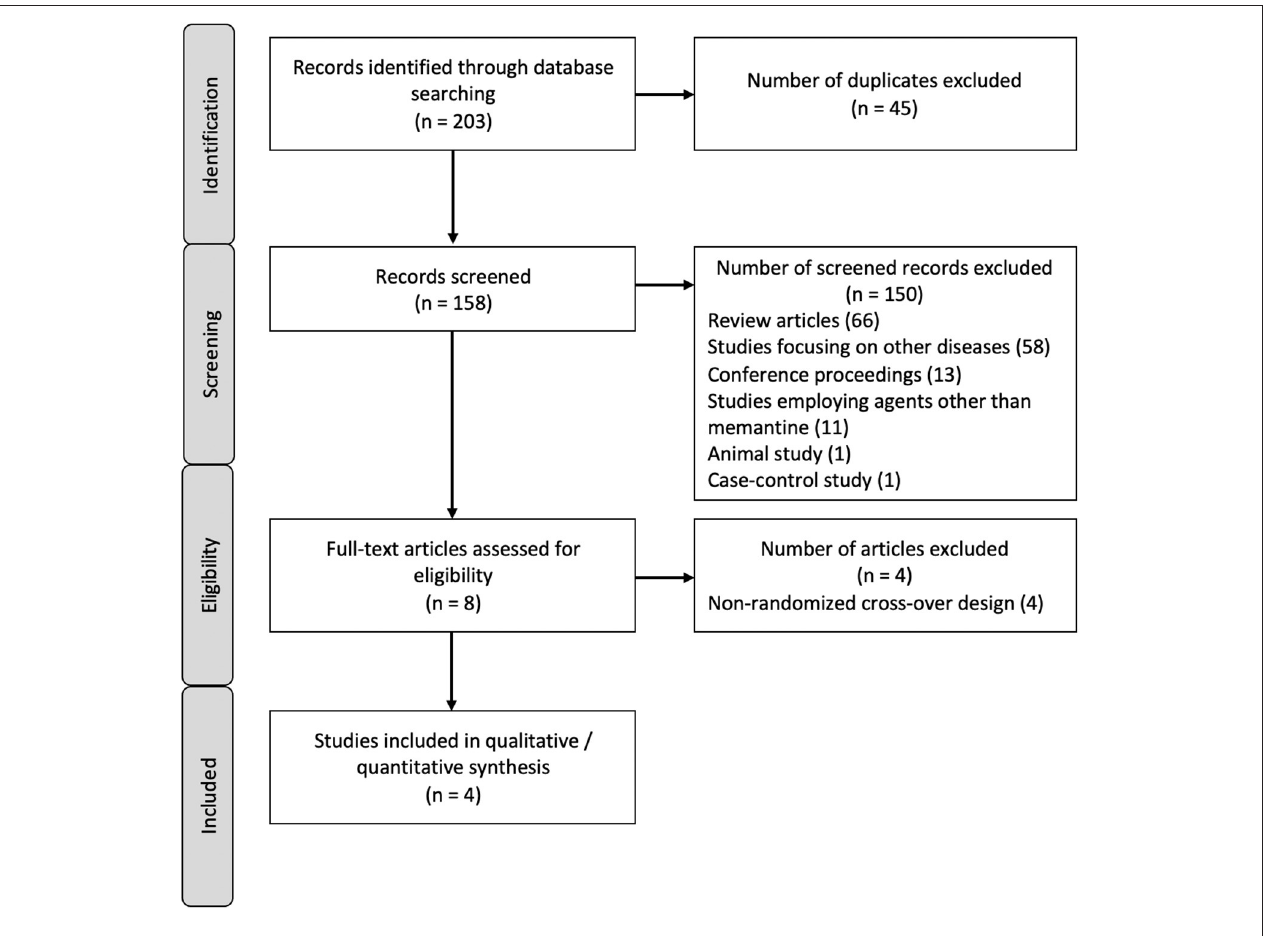
FIGURE 1 | PRISMA flow diagram. TABLE 1 | Included studies, corresponding treatment arms compared, sample characteristics, and outcome